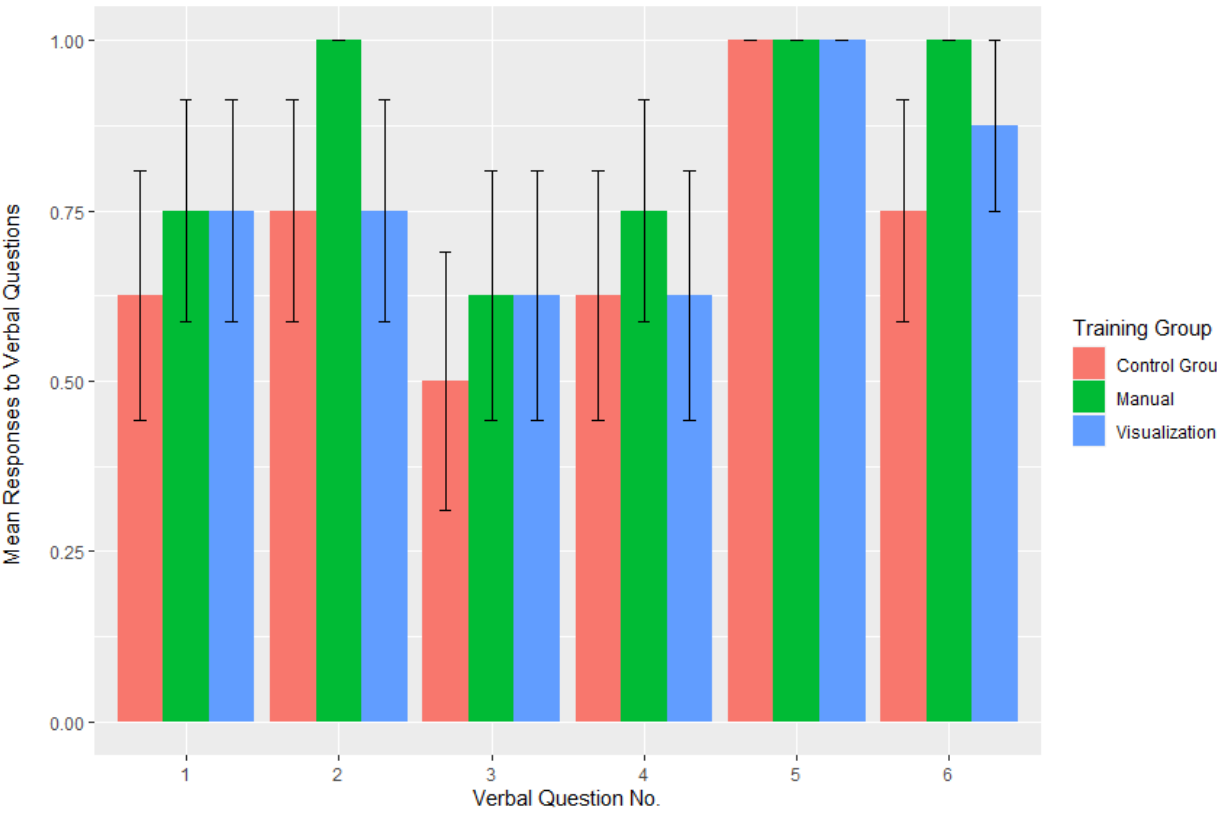
Figure 4 Drivers’ verbal response accuracy to buy the